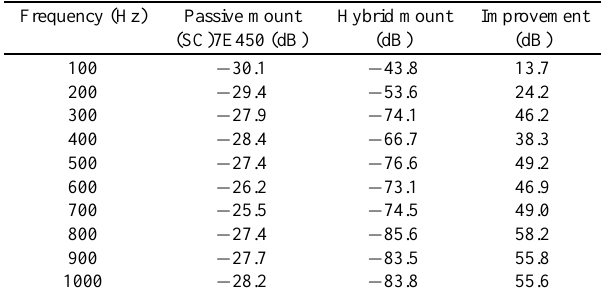
Fig. 15. Photograph of shock test. Table 7 Control performances of the hybrid